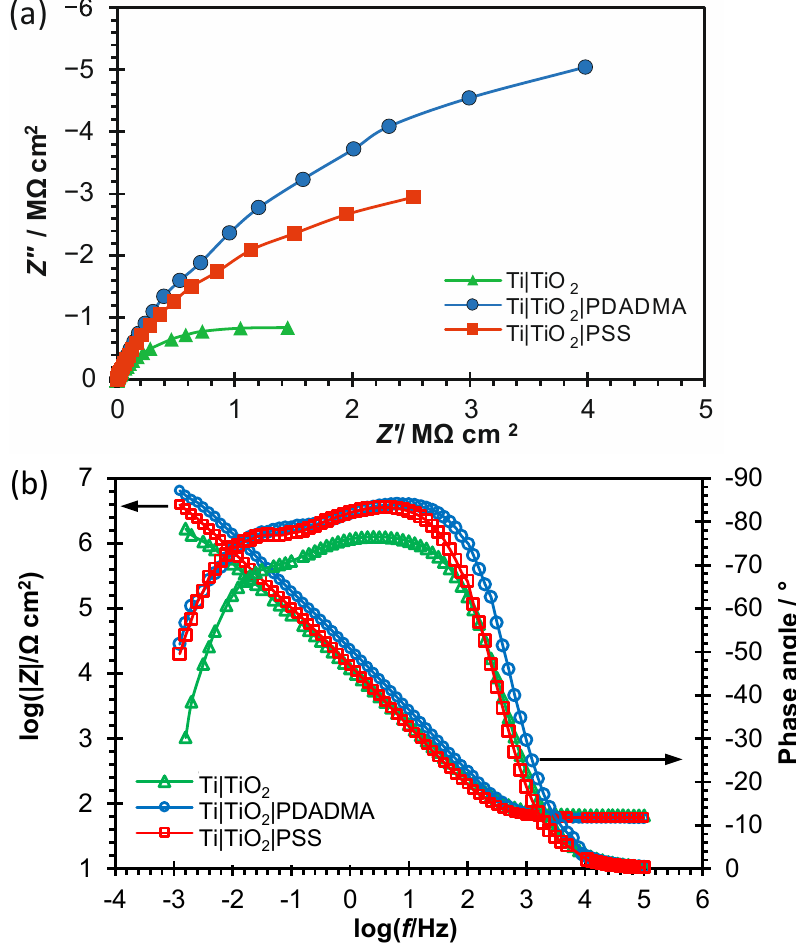
Figure 4. The Nyquist ( a ) and Bode ( b ) plots of the unmodified (Ti|TiO 2 ) and polyelectrolyte modi- fied Ti electrodes (Ti|TiO 2 |PSS and Ti|TiO 2 |PDADMA) recorded at the open circuit potential ( E OC ) in 0.1 mol dm − 3 NaCl electrolyte solution after 1-h stabilization. Symbols present the experimental data and solid lines present the modeled data.